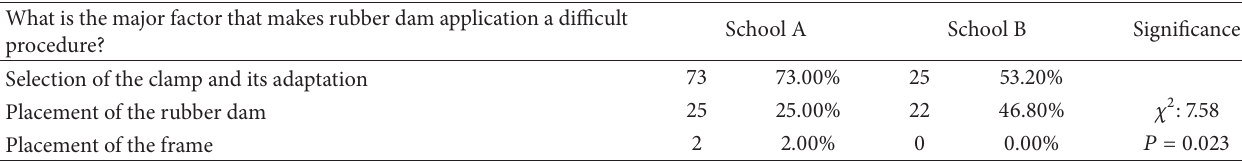
Table 3: Opinions of students about the most difficult aspect regarding rubber dam